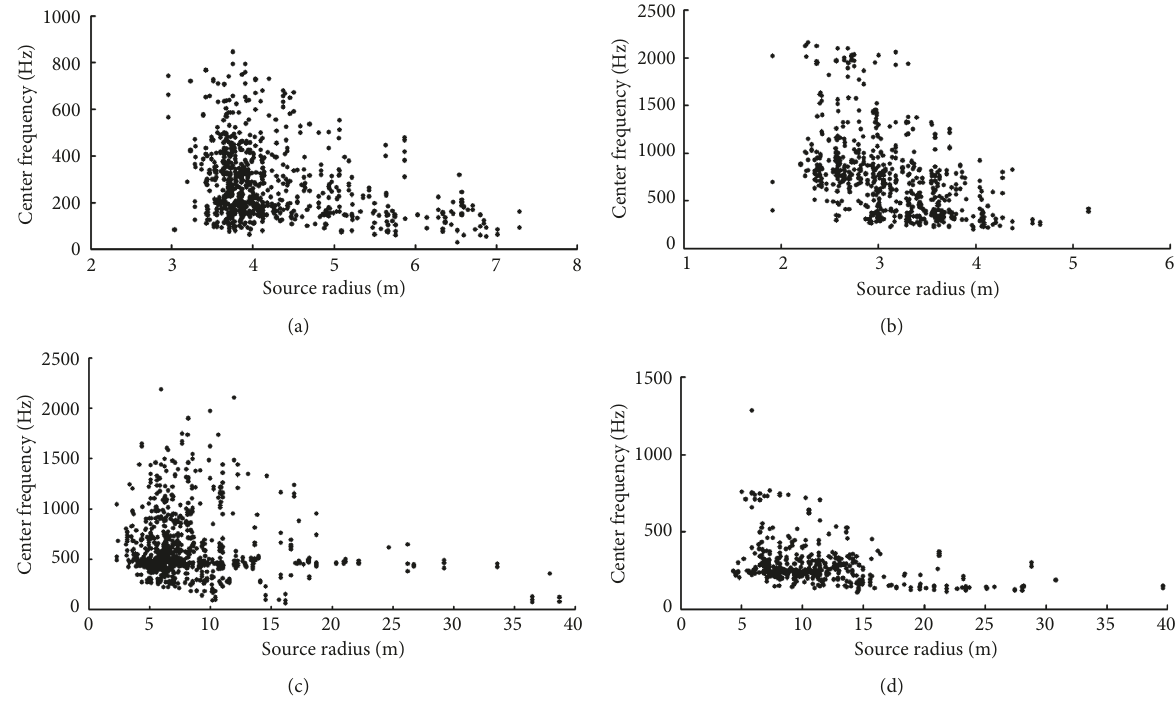
Figure 2: Relationship between source radius and frequency characteristic in each engineering project: (a) Jinping project during ex- cavation, (b) Jinping project during impoundment, (c) Houziyan project, and (d) Baihetan